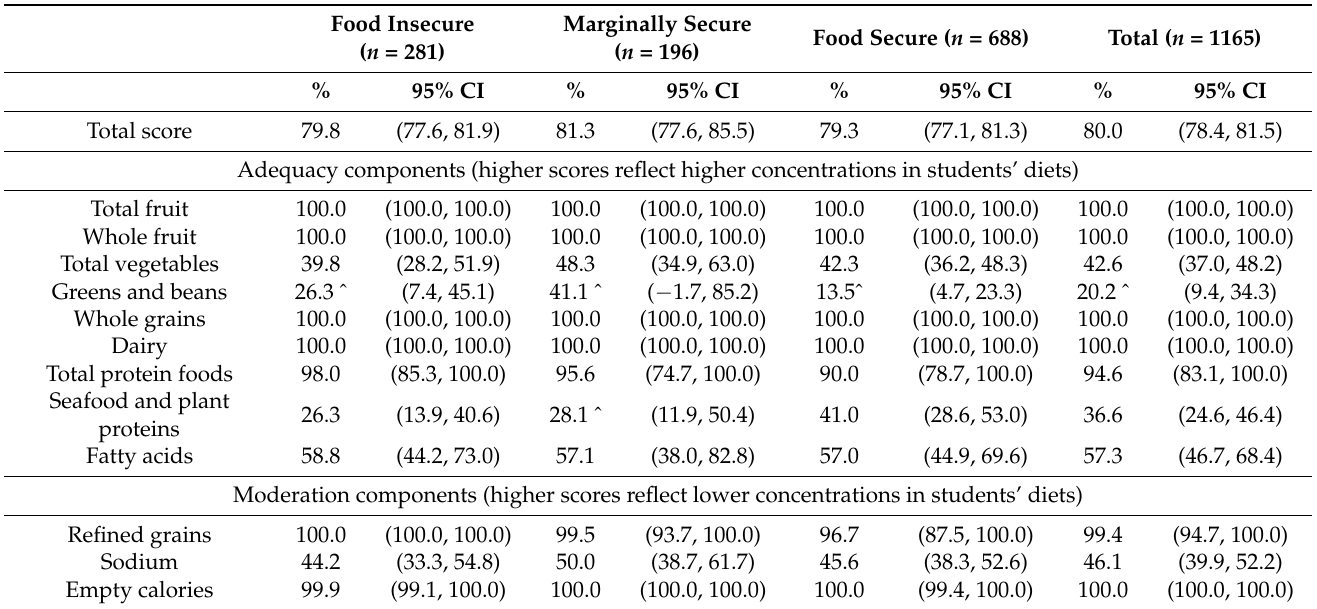
Table 5. HEI-2010 total and component scores, expressed as the mean percentage of the maximum score, for all NSLP and SBP foods consumed by school meal participants, by food security status 1 .